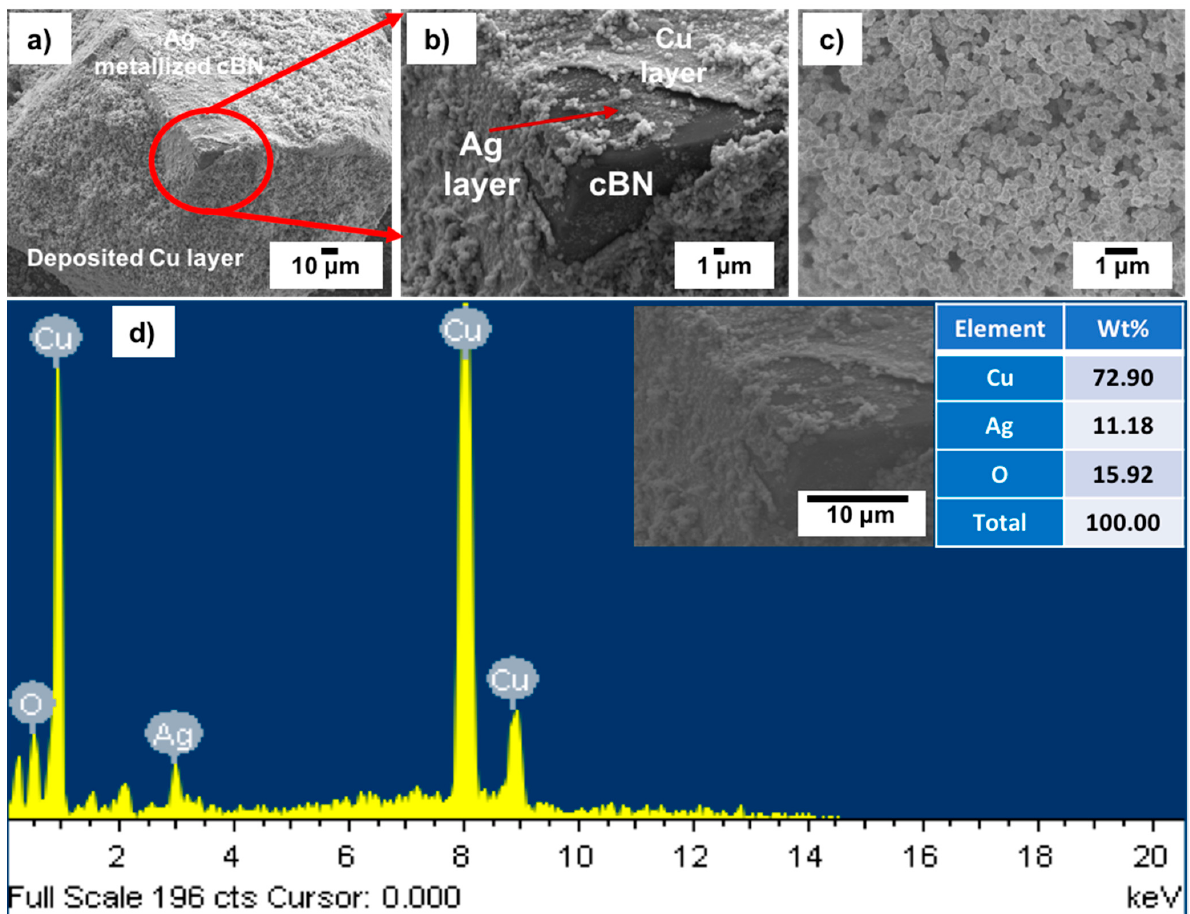
Figure 11. ( a – c ) FESEM images with different magnification and ( d ) EDAX spot compositional analysis of the Tin/Silver- metallized cBN/Cu composite particles.